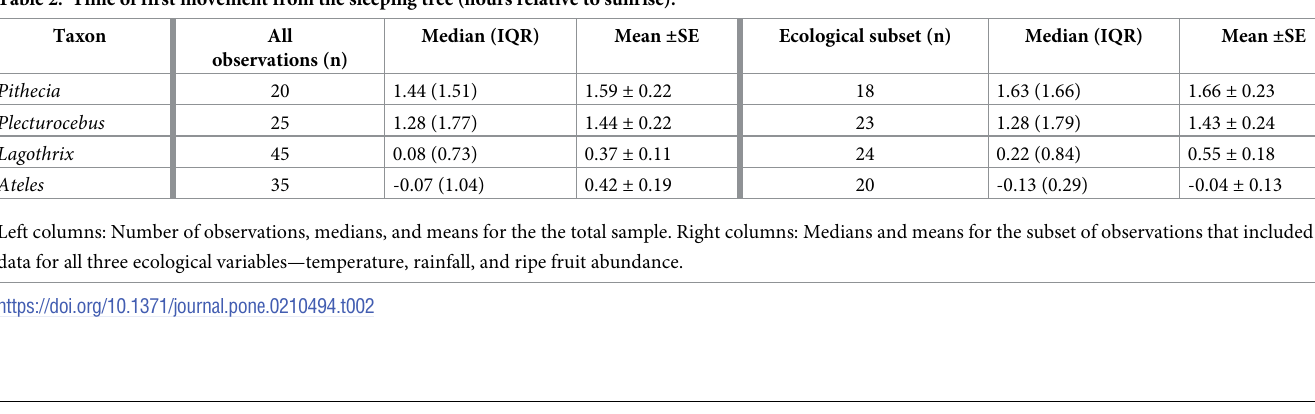
Table 2. Time of first movement from the sleeping tree (hours relative to sunrise). Taxon